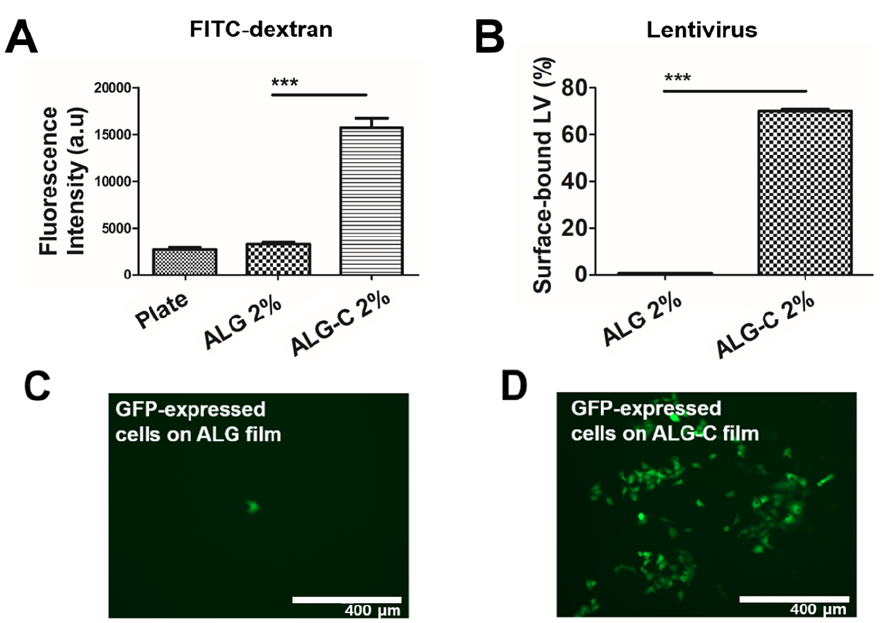
Figure 6. The drug loading efficacy of ALG-C film. The ALG-C film showed a significantly higher drug loading efficacy of both ( A ) FTIC-dextran and ( B ) lentivirus than that of ALG film. Representa- tive images of the transfected cells on the lentivirus-coated ( C ) ALG film and ( D ) ALG-C film. All the experiments were conducted in triplicate. (*** p < 0.001).